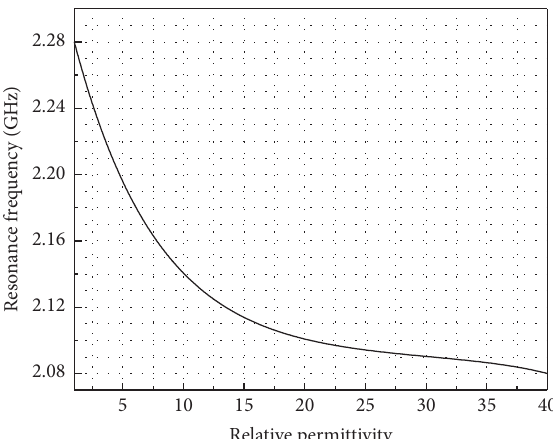
Figure 8: Relationship between the different relative permittivity values of the microfluidic channels and the resonant frequency of the antenna.